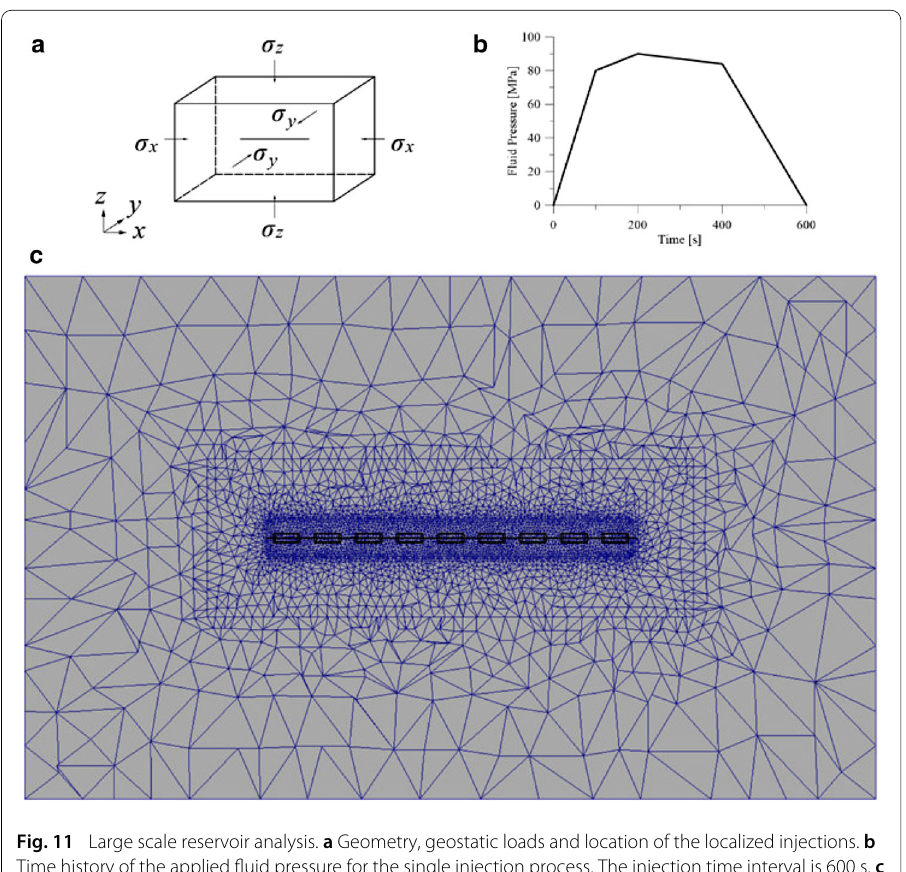
Fig. 11 Large scale reservoir analysis. a Geometry, geostatic loads and location of the localized injections. b Time history of the applied fluid pressure for the single injection process. The injection time interval is 600 s. c